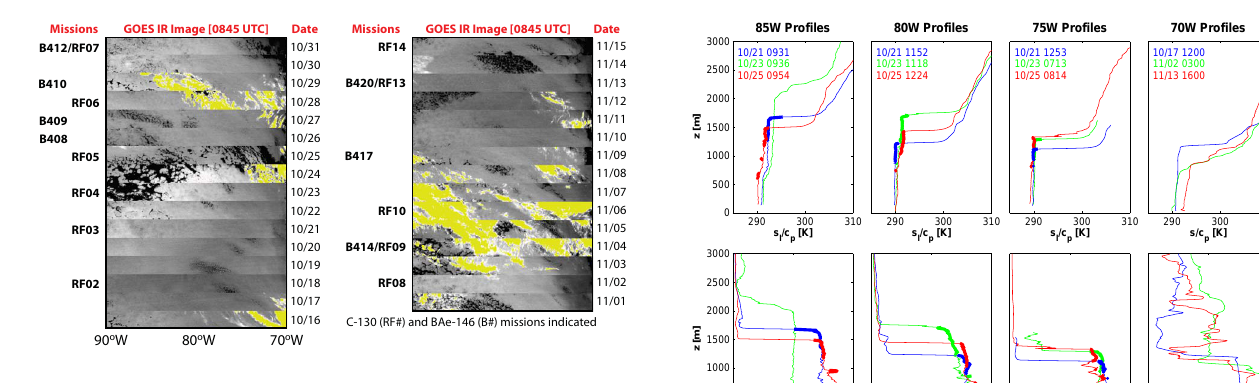
Fig. 3. GOES 12µm infrared brightness temperature at 08:45UTC daily from 19–21 ◦ S, 70–90 ◦ W; C130/BAe146 missions with a substantial 20 ◦ S component are indicated at left.